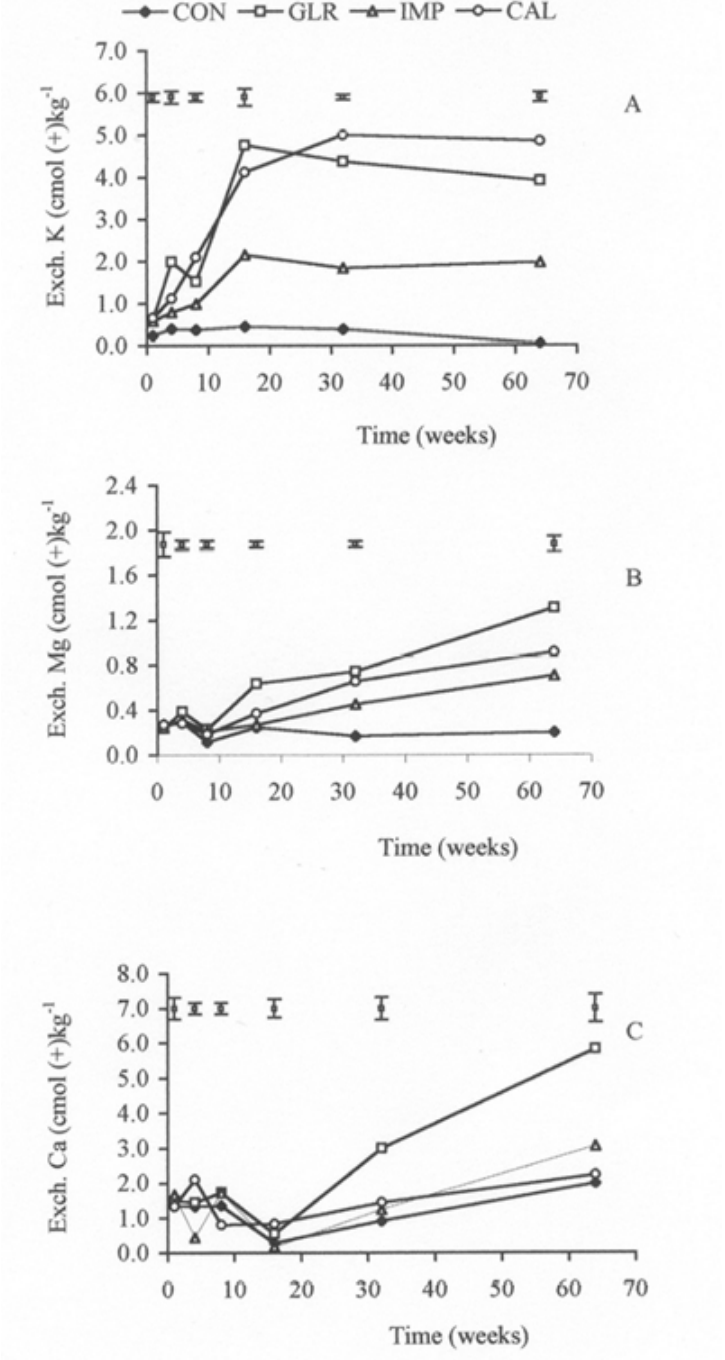
FIGURE 4. Changes in (A) exchangeable K, (B) Mg, and (C) Ca in a tropical soil treated with GMs and PRs. Bars = LSD 0.05